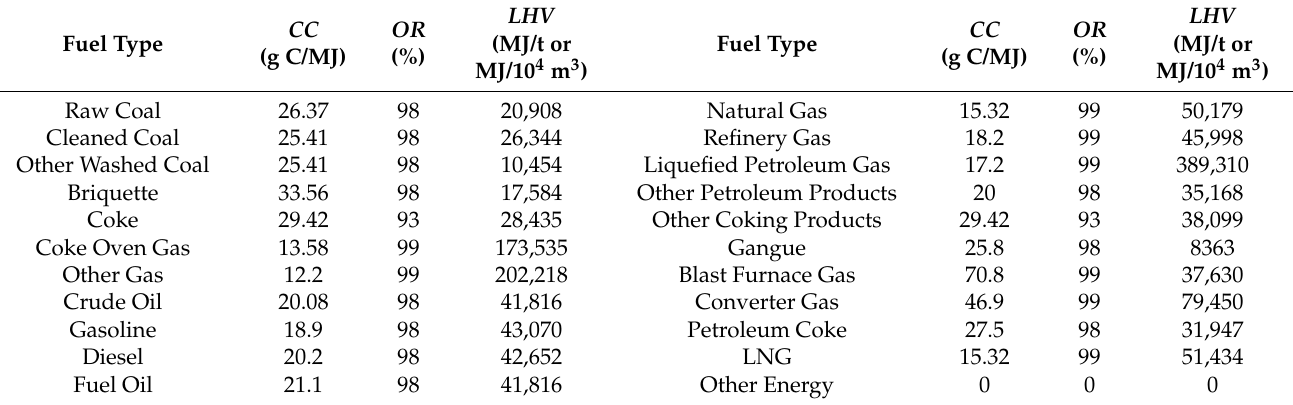
Table 1. LHV , CC , and OR of main fuel types